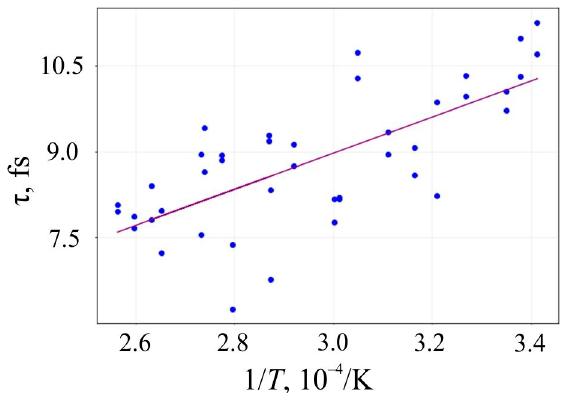
Figure 7. Lifetime of the oligomer O4 before its decay versus the inverse initial temperature T − 1 : circles are the results of the numerical calculation, and a solid line is the corresponding linear approximation obtained by the least-square method.